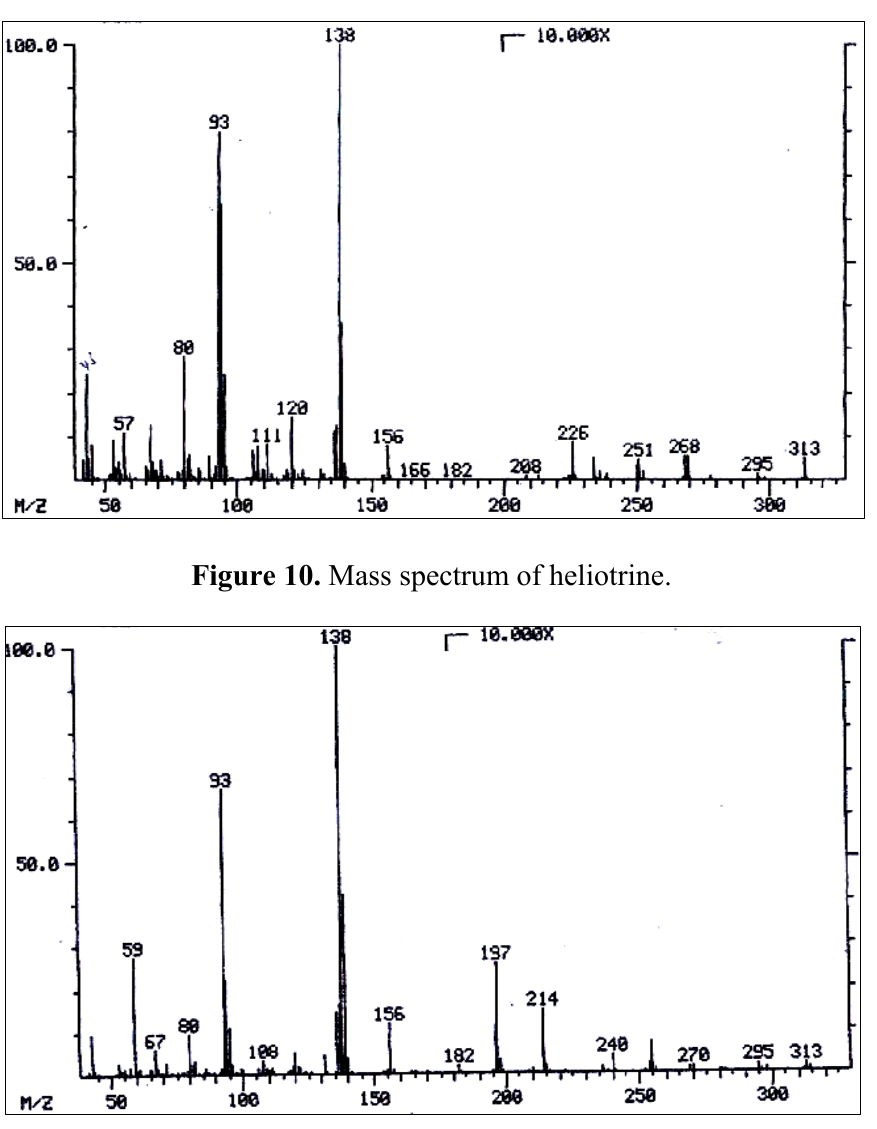
Figure 9. Mass spectrum of 9-curassavoylheliotridine.